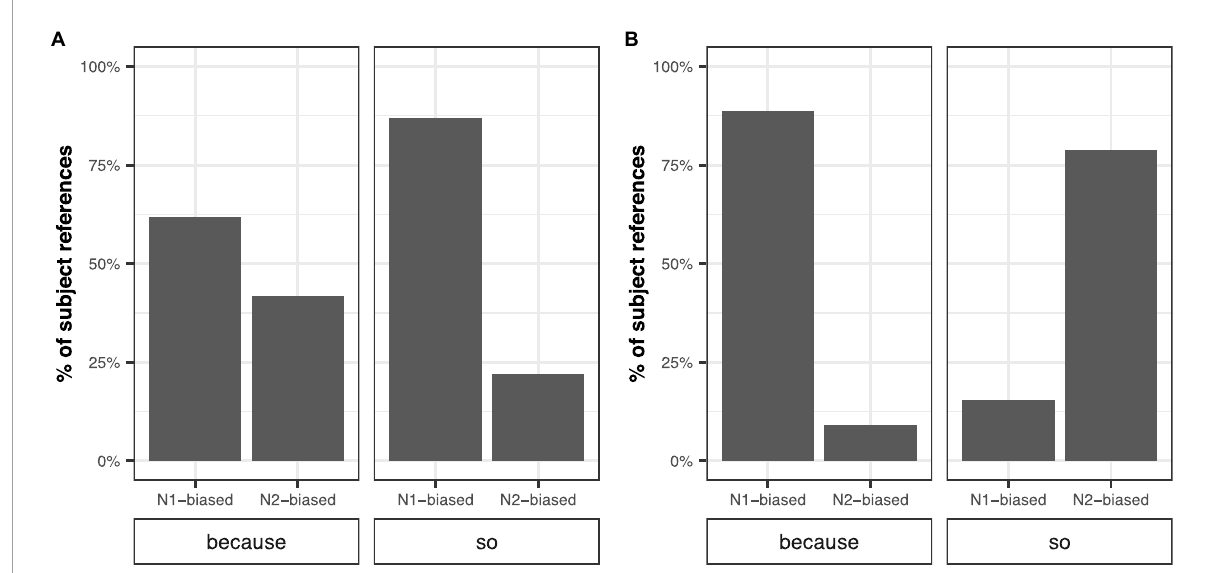
FIGURE1 Percentages of subject reference by verb type [subject (N1)-biased vs. object (N2)- biased] and connective (“because” vs. “so”) for transfer verbs (A) and IC verbs (B) .